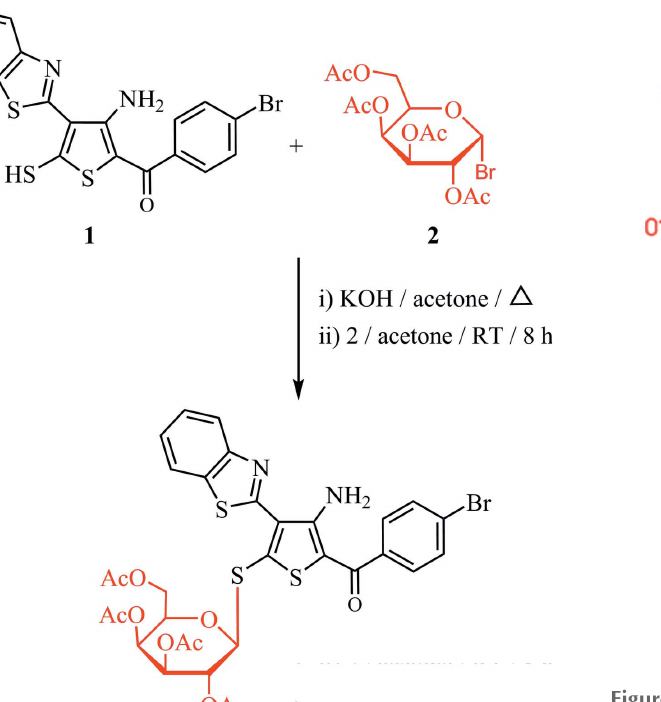
Figure 2 The molecule of 3 in the crystal. Ellipsoids represent 50% probability levels. The dashed lines indicate intramolecular hydrogen bonds.